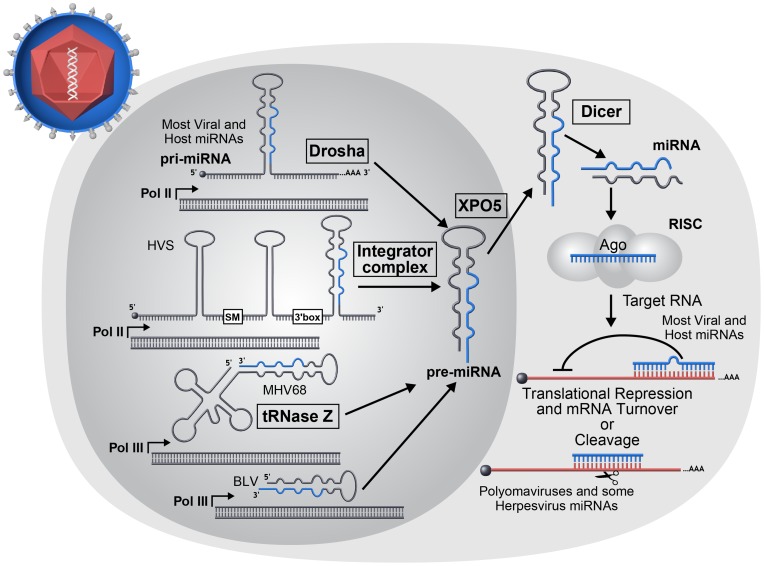
miRNA biogenesis overview.The majority of host and viral miRNAs begin as longer RNAs (pri-miRNAs) transcribed by host RNA Pol II that are recognized and processed by the host Microprocessor complex to produce a short stem-loop RNA (pre-miRNA). However, a minority of viruses utilize noncanonical mechanisms in the biogenesis of pre-miRNA molecules. Herpesvirus saimiri (HVS) encodes Sm class U RNAs (HSURs) that are transcribed by RNA Pol II and subsequently processed by the host Integrator complex to generate pre-miRNAs [115]. The miRNAs encoded by mouse gammaherpesvirus 68 (MHV68) and BLV are both transcribed by host RNA Pol III [35], [39], [116], [117]. The MHV68 miRNAs are processed from larger tRNA-like RNAs by host tRNase Z and possibly additional factors to generate pre-miRNAs. Pre-miRNAs are exported to the cytoplasm where they are cleaved into short ∼22 nt duplex RNAs by the host enzyme Dicer. One strand of the duplex may be incorporated into an Argonaute protein containing effector complex known as RISC. The incorporated miRNA directs RISC to target RNAs. Most commonly for animal host and virus-encoded miRNAs, imperfectly complementary base pairing occurs between miRNA and mRNA target resulting in translation inhibition and mRNA turnover. However rarely, perfect base pairing can occur resulting in siRNA-like RNA cleavage and has been reported for polyomaviruses and some herpesviruses.